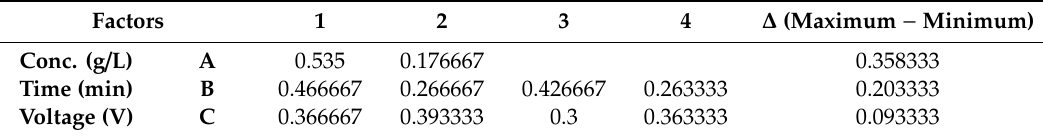
Table 4. Mean of mean response for the deposition yield of zein / HA coatings.